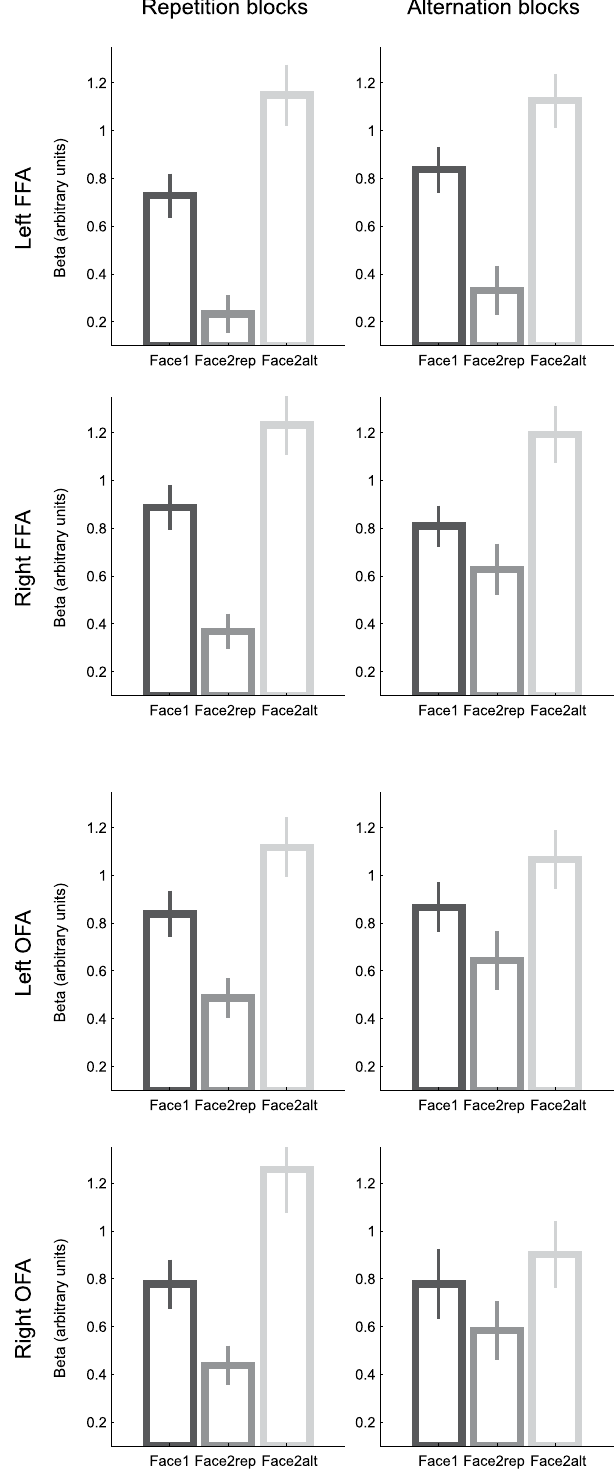
Figure 2. Parameter estimates (mean ± s.e.m. across 28 participants) for Face1, Face2alt and Face2rep, in the left FFA, right FFA, left OFA, and right OFA, during Repetition Blocks (left) and Alternation Blocks